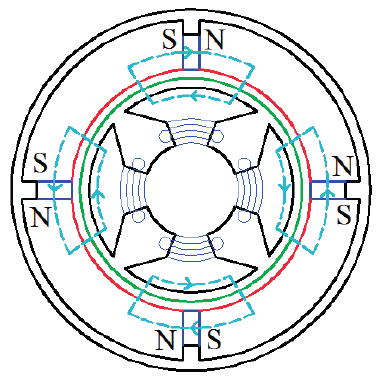
Figure 5. The magnetic circuit of Ф P .